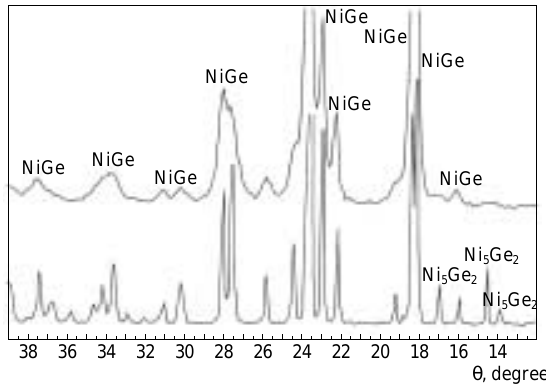
Fig. 6 X-ray patterns of the SHS product in the system Ni 55 wt.% Ge (a), the same product after mechanical activation for 2